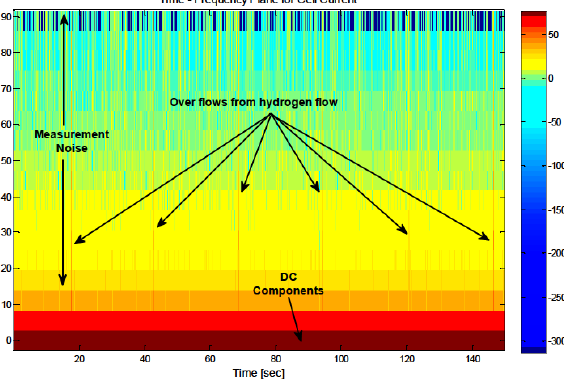
Figure 5: Semi-Logarithmic Power Spectral Density (PSD) variation for current measurement.